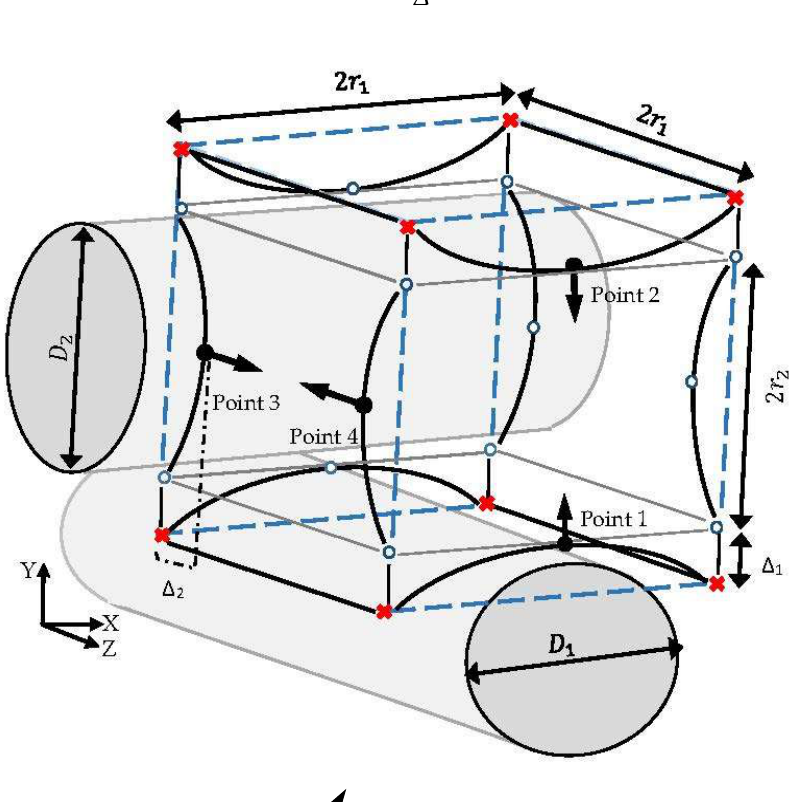
Figure 4. The studied unit: fixed point, indicator point, free point, imaginary cube edges.